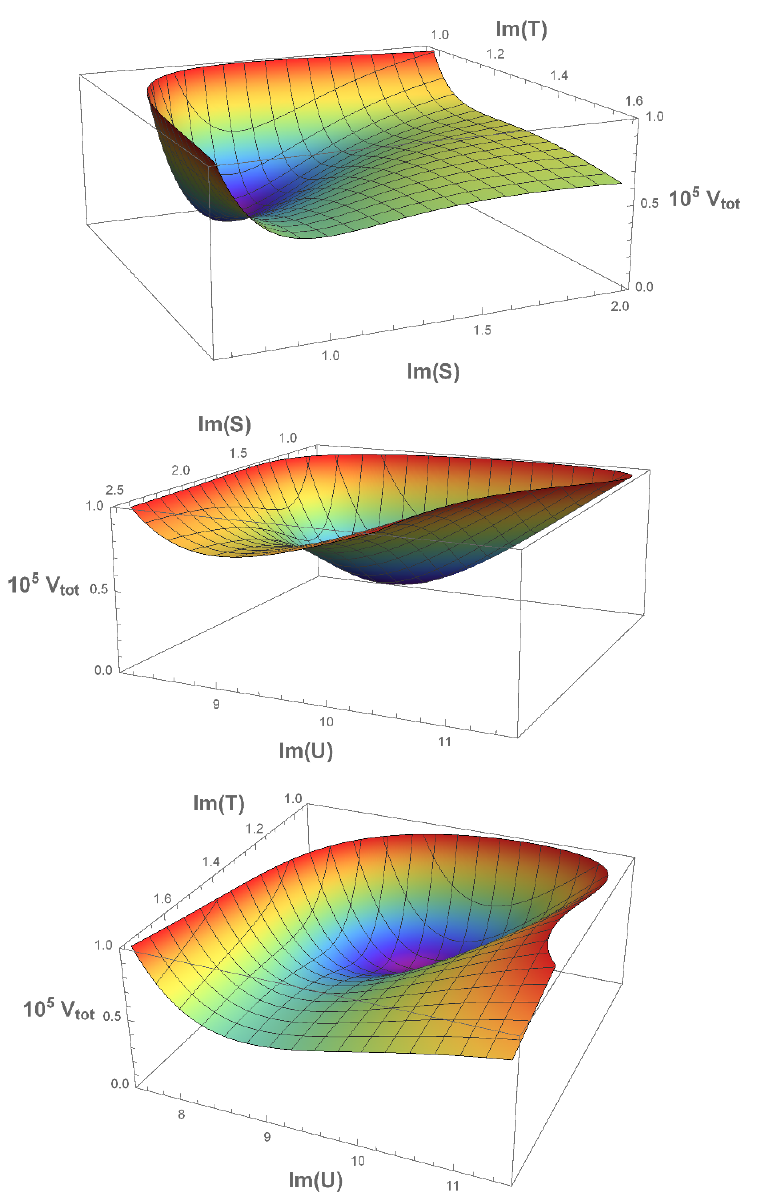
Figure 2 . 3D plots of the de Sitter potential for the Set 2 of parameters. We have the following slices. Top: Im( S ) and Im( T ), Middle: Im( S ) and Im( U ), Bottom: Im( U ) and Im( T ). In all three di(cid:11)erent plots the de Sitter minimum is clearly visible and it is metastable.